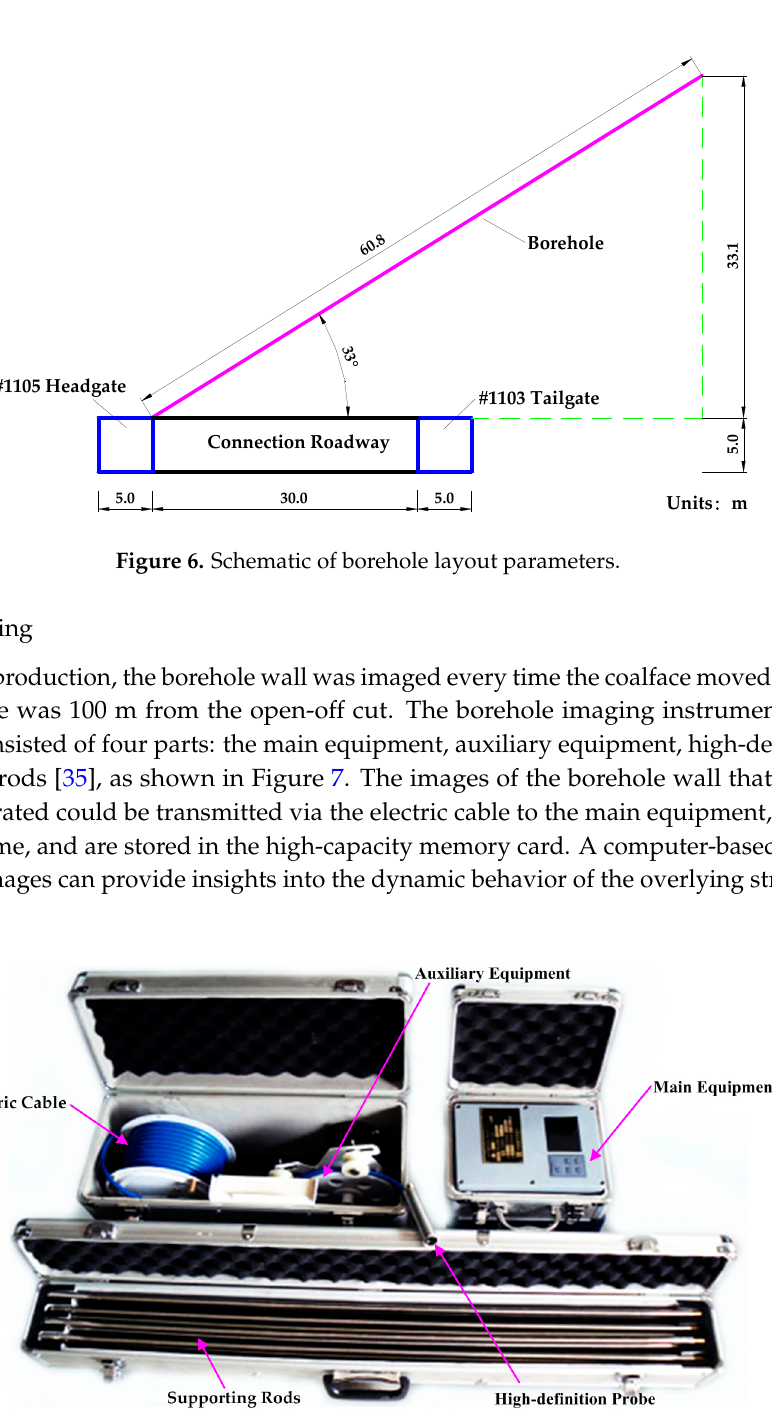
Figure 7. Structural composition of the borehole imaging instrument.